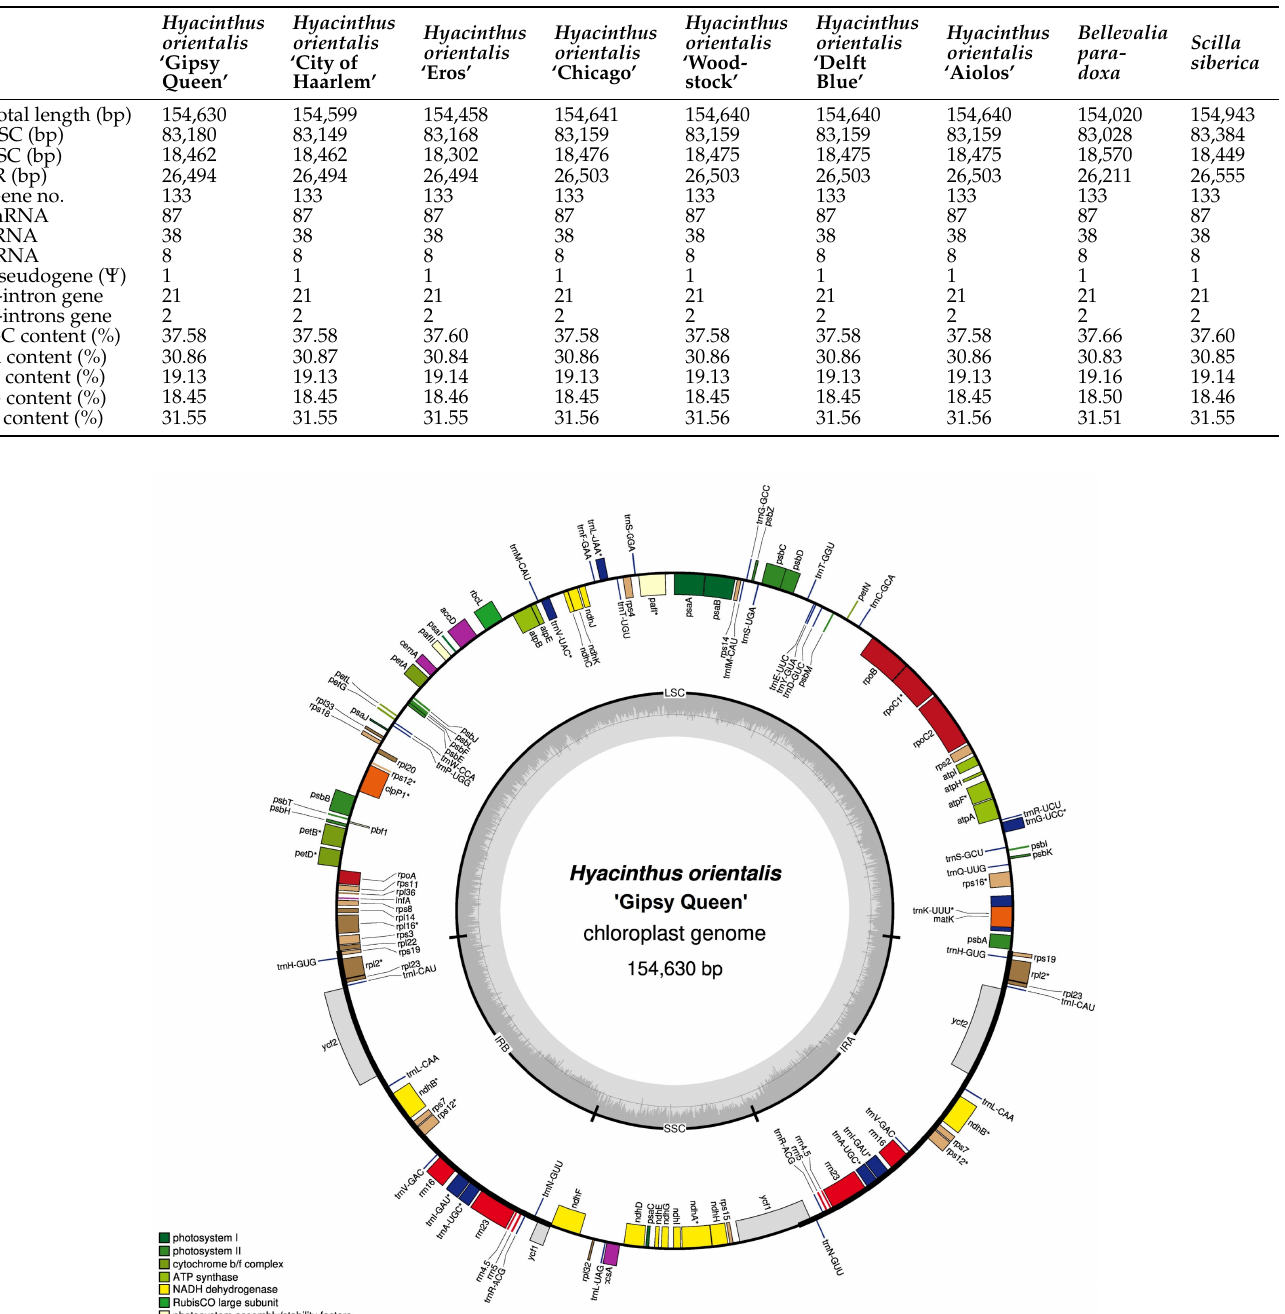
Table 2. Summary of the chloroplast genome structures of the studied specimens.